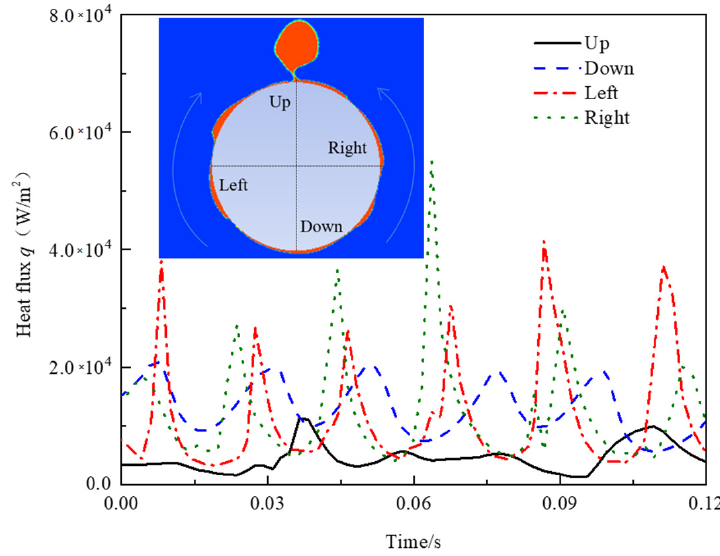
Figure 13. The heat flux at four typical positions of the 25 mm tube heater during film boiling.